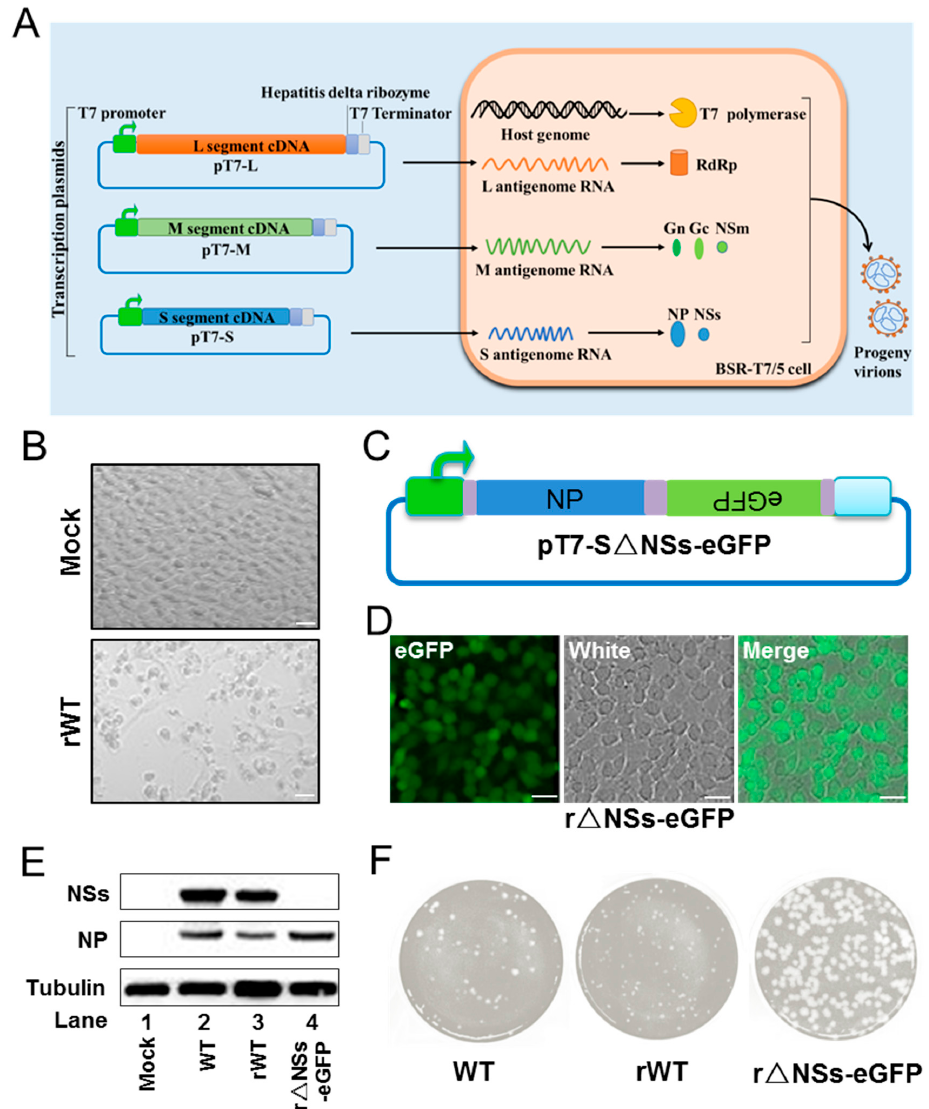
Figure 1. Rescue of RVFV BJ01 and a mutant lacking the NSs gene. ( A ) Schematic of the T7 RNA polymerase-dependent reverse genetics system for construction of recombinant viruses Adapted from the Box 2 figure of Orthobunyaviruses: recent genetic and structural insights [18]. ( B ) Cytopathic e ff ect (CPE) of rescued virus in BHK-21 cells. BHK-21 cells were mock treated or infected with rWT at an MOI of 5, images were captured at 48 h p.i. Bars, 20 µ m. ( C ) Construction of the plasmid encoding the S segment in which the NSs gene was replaced by eGFP. ( D ) Fluorescence microscopy analysis to verify the successful rescue of r (cid:52) NSs-eGFP. BHK-21 cells were infected with r (cid:52) NSs-eGFP (MOI = 5) and the fluorescence images were acquired at 72 h p.i. Bars, 20 µ m. ( E ) Western blot analysis of infected cells with anti-N, anti-NSs and anti-Tubulin antibodies. Vero cells were infected with WT, rWT and r (cid:52) NSs-eGFP at an MOI of 1 and cell lysates were harvested at 24 h p.i. ( F ) Plaque assay of RVFV WT and rescued viruses (rWT and r (cid:52) NSs-eGFP) on Vero cells. After 7 days of incubation, plaques were stained with crystal